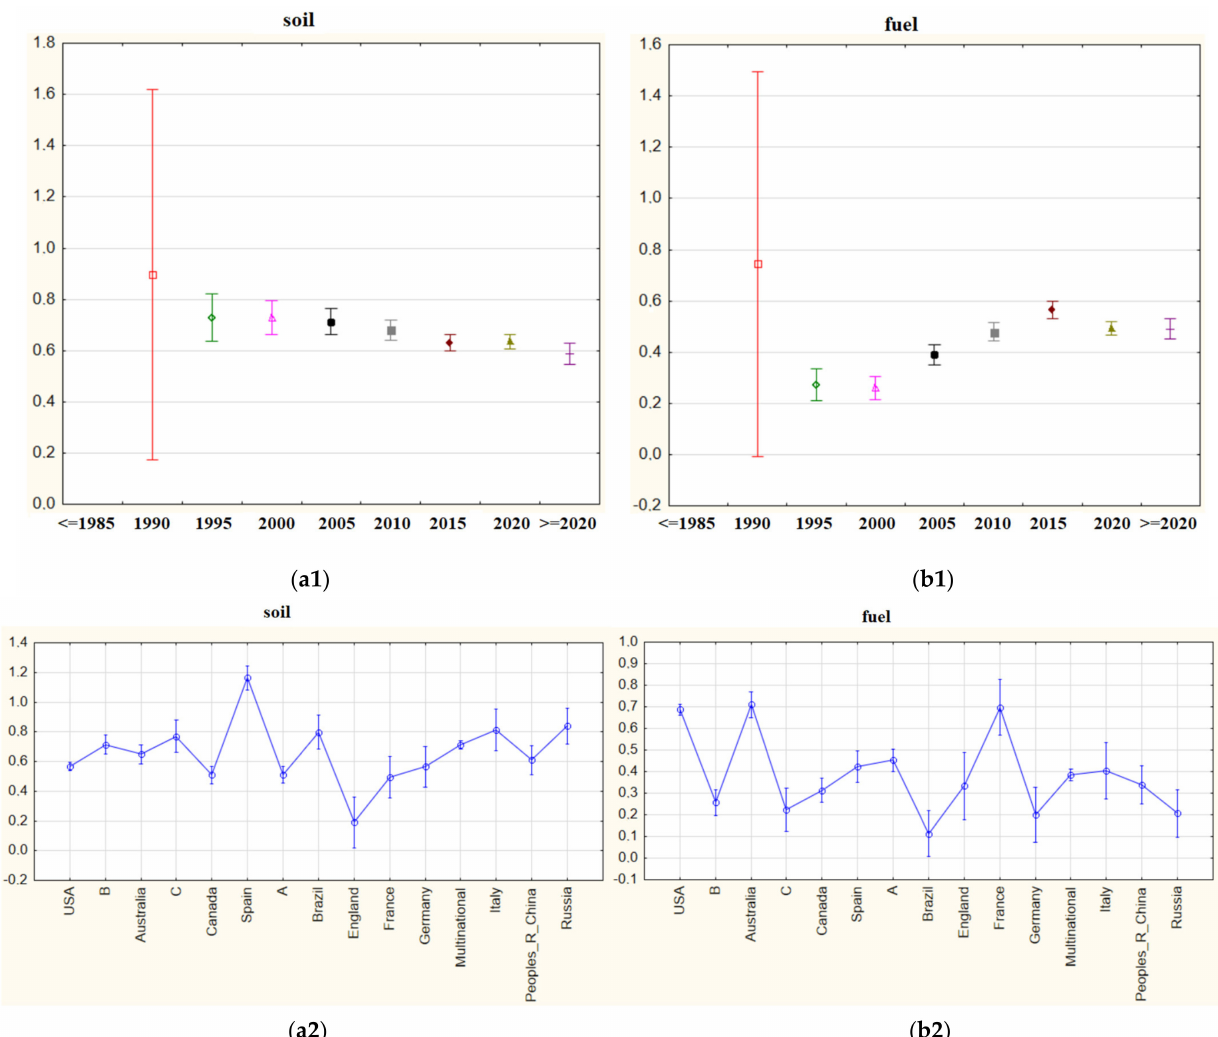
Figure 8. ( a1 ) mean importance weights of the indexed word “soil” for five-year periods; ( b1 ) mean importance weights of the indexed word “fuel” for five-year periods; ( a2 ) mean importance weights of the indexed word “soil” via countries; ( b2 ) mean importance weights of the indexed word “fuel” via